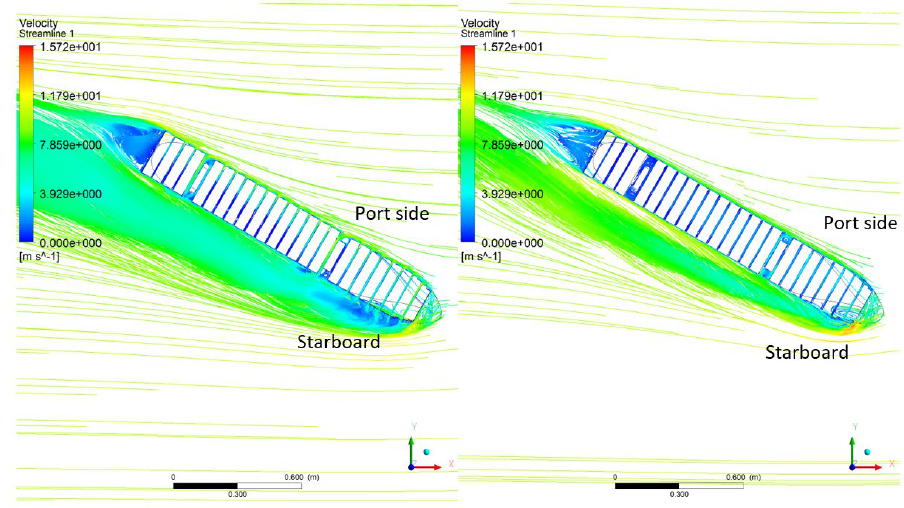
Figure 32. Streamline from z = 0.12 m, ψ = 30 degrees. (Left: without side covers; Right: with side covers).